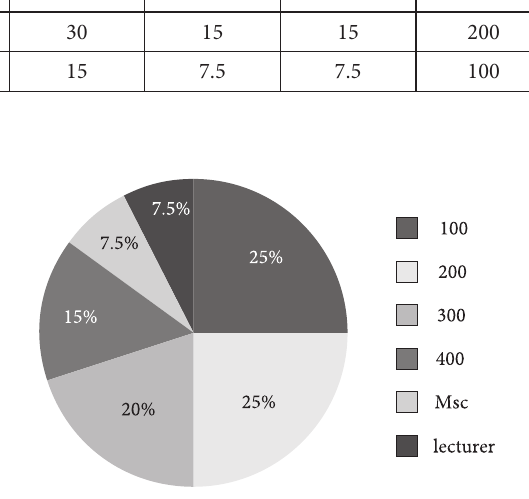
Fig. 2. Pie charts showing percentages of questionnaire